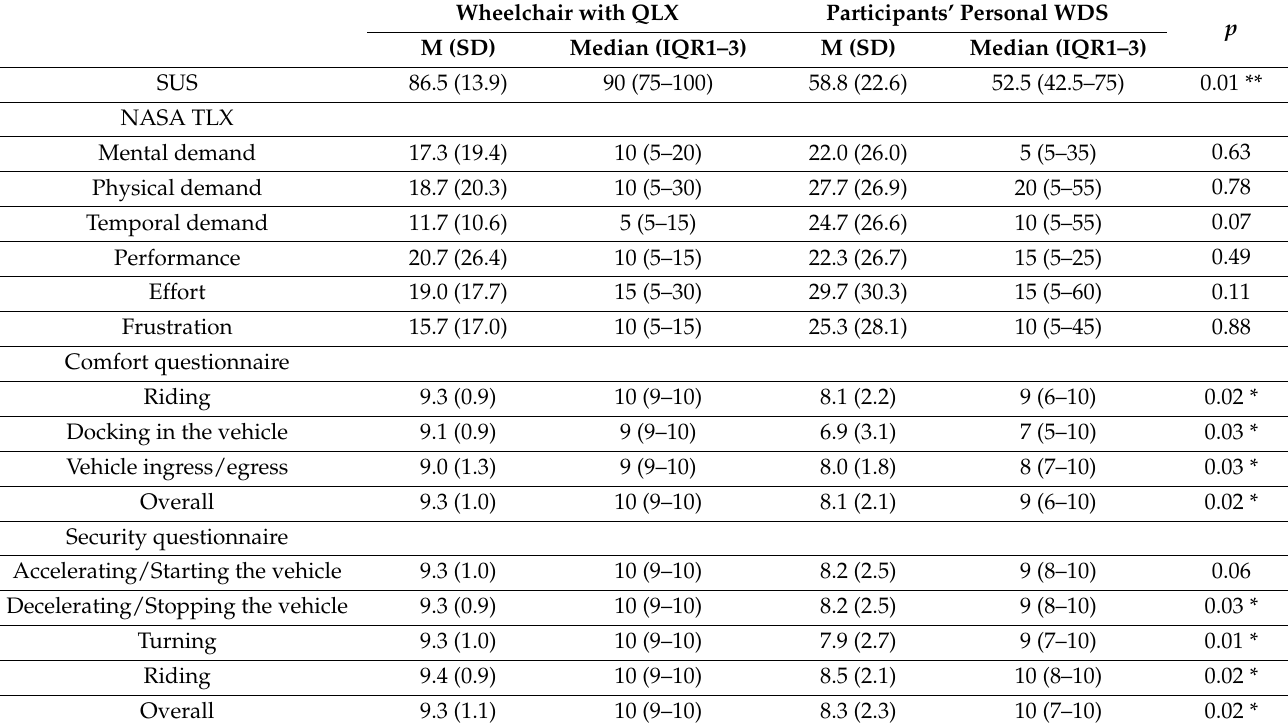
Vehicle riding test results: Participants reported higher SUS scores using the wheelchair with QLX compared to their own WDS (4-TD and EZ-Lock) ( p < 0.001) (Table 3). However, participants reported no significant differences in NASA TLX results between the QLX and both WDS. The comfort questionnaire results showed that participants felt significantly more comfortable with the QLX compared to participants’ WDSs for all vehicle riding tasks (all p ’s < 0.05). The security questionnaire showed that participants reported feeling more secure riding in a vehicle with the QLX compared to participants’ WDS for all vehicle riding tasks (all p ’s < 0.5), except when starting and accelerating the vehicle. Table 3. Vehicle riding test results (n =